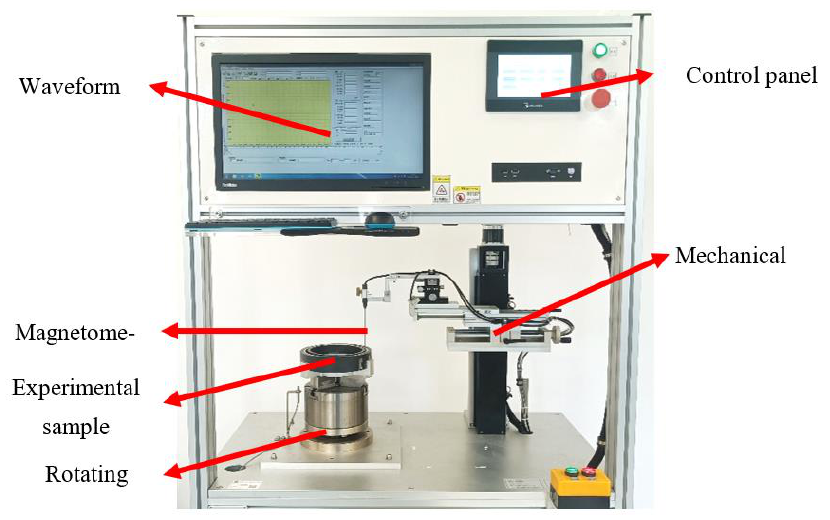
Figure 10. Air-gap magnetic field testing system.